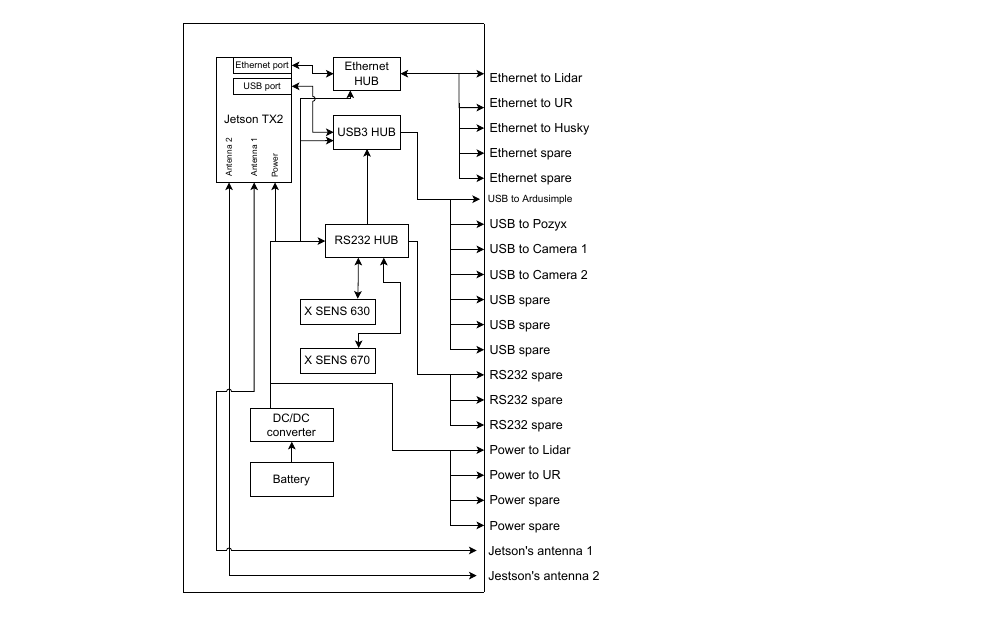
Figure 3. Configuration of the electronics and of the high-level control box.